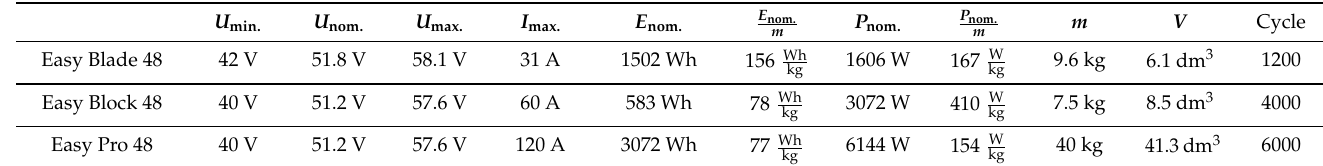
Figure 1. Qualitative comparison of two methods to meet the requirements: ( a ) With an oversized bat- tery with either 1. power, 2. energy or 3. oversized super-capacitor; ( b ) A hybrid solution consisting of the combination of the battery with a super-capacitor module to meet the requirements [11]. Table 1. Overview of three commercially available battery systems for AGV’s from the company Varta